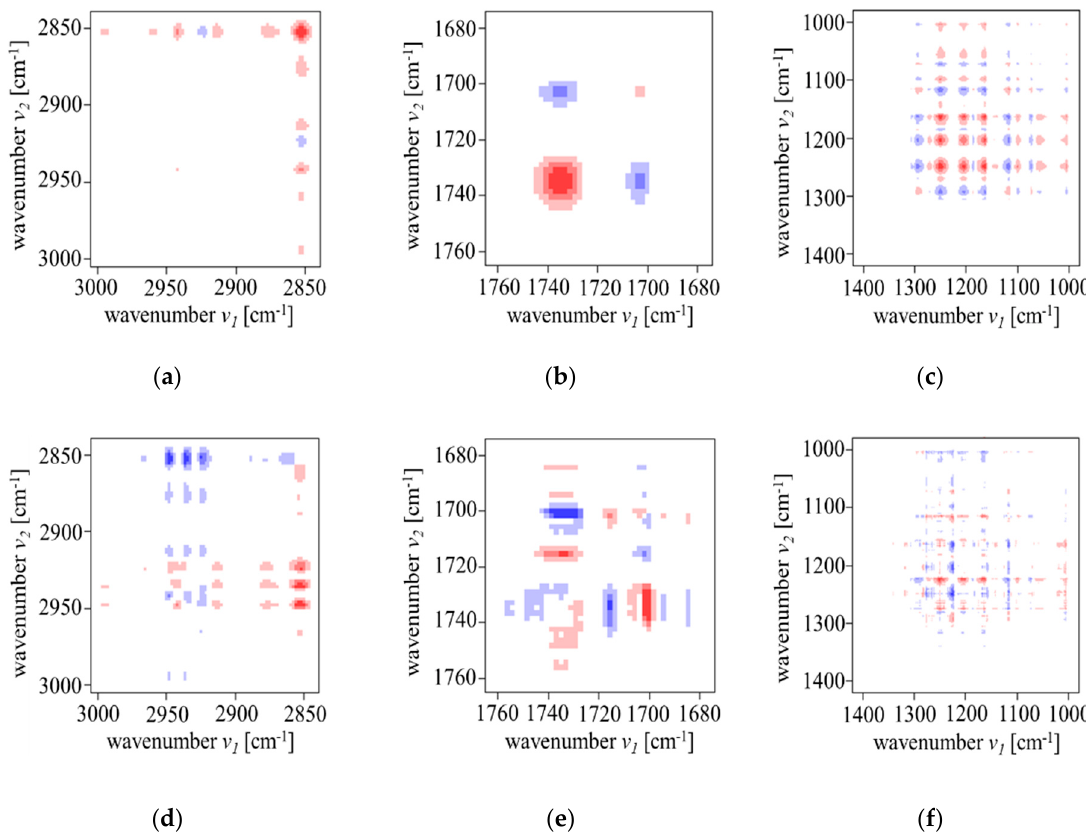
Figure A3. 2D-COS correlation ( a – c ) synchronous and ( d – f ) asynchronous maps of 3F7HPhH7 in the heating mode from 339 to 389 K in the wavenumber regions of: ( a , d ) 3000–2840 cm − 1 , ( b , e ) 1770–1670 cm − 1 and ( c , f ) 1400–1000 cm − 1 . The red or blue areas represent positive or negative correlation intensities, respectively.